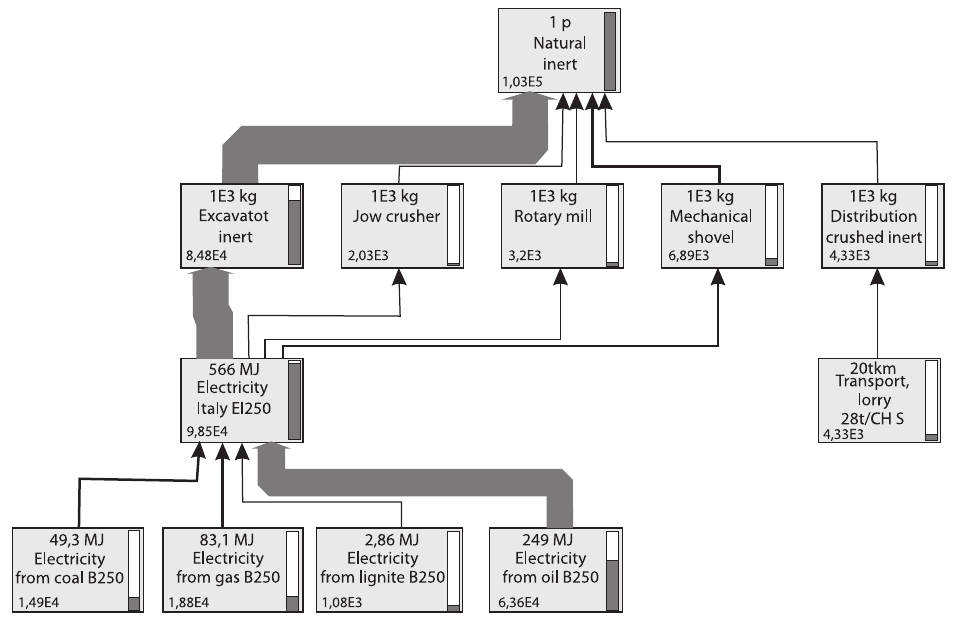
Fig. 9. Mass balance flow sheet (Sankey diagram) for CO associated to GWP impact category